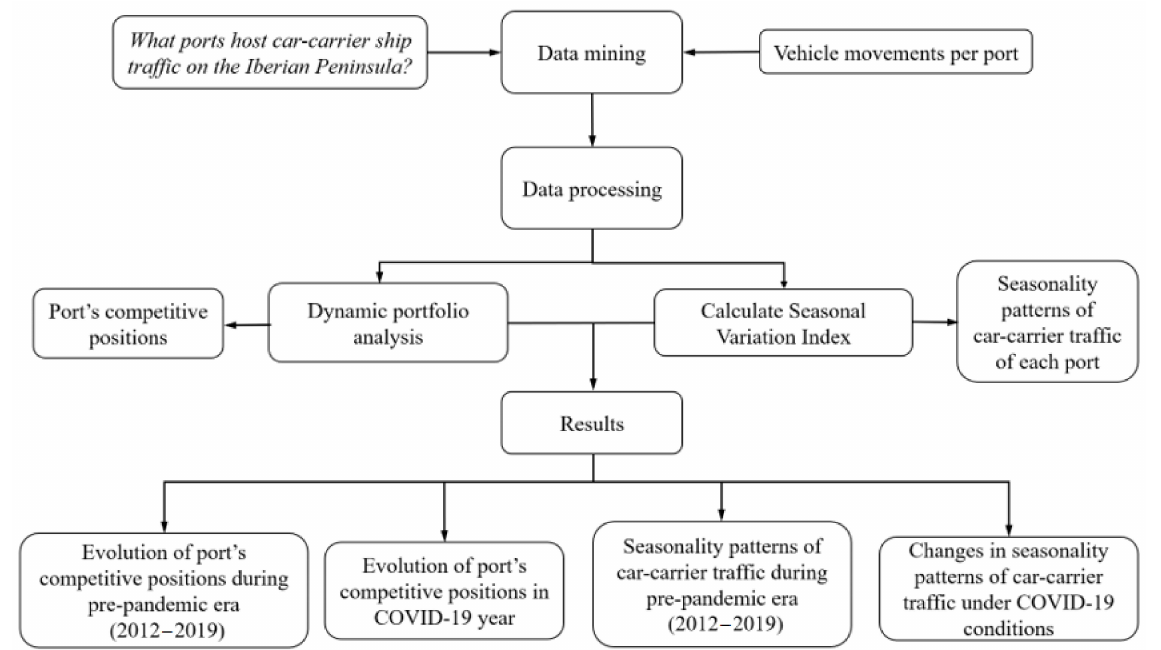
Figure 2. Diagram of the process carried out in the research.